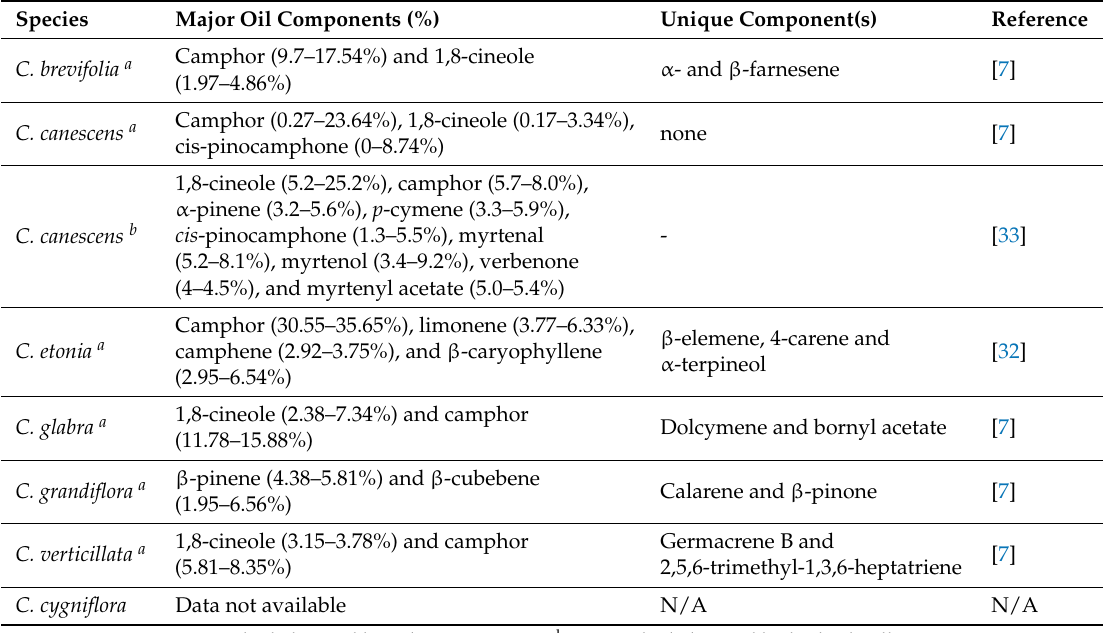
Table 2. Chemical composition of essential oils of Conradina